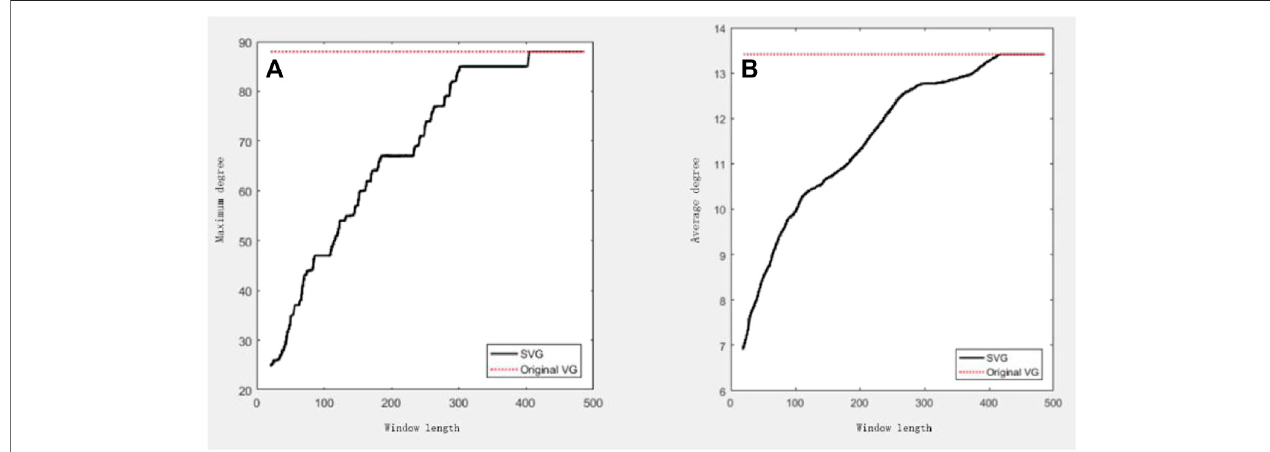
FIGURE8| Illustrationoftherelationshipbetweenincorporatedparameterand W throughSVG.Here,atwo-yearstockopeningpricedataforPingAnBank Co.is considered. (A) maximum degree; (B) average degree.